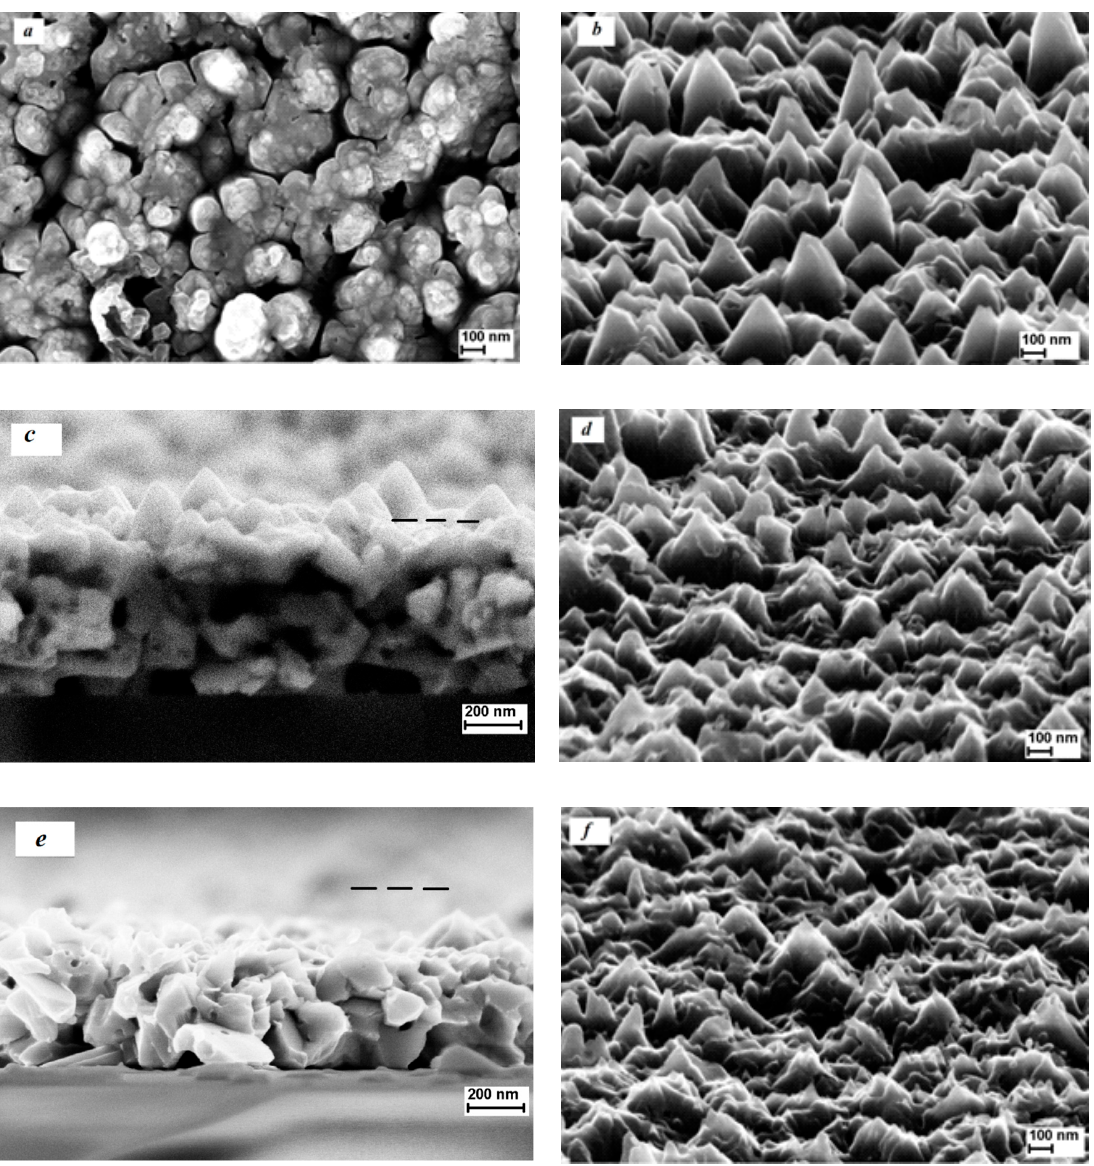
Figure 4. SEM images of the film surface after plasma sputtering at ion energy of 200 eV and processing times of 30 s ( a , b ), 60 s ( c , d ), and 90 s ( e , f ). The sample tilts during imaging were 0° ( a ) and 70° ( b , d , f ). ( c ) and ( e ) show cross-sections of the film. The dashed line in ( c , e ) shows the upper border of the lower layer in Figure 1c. The X-ray diffractograms of the samples after plasma treatment at ion energies of 25 and 200 eV for durations of 60 and 90 s are presented in Figure 5. The results of the X-ray diffractometry indicate a change in the phase composition during ion sputtering. In the